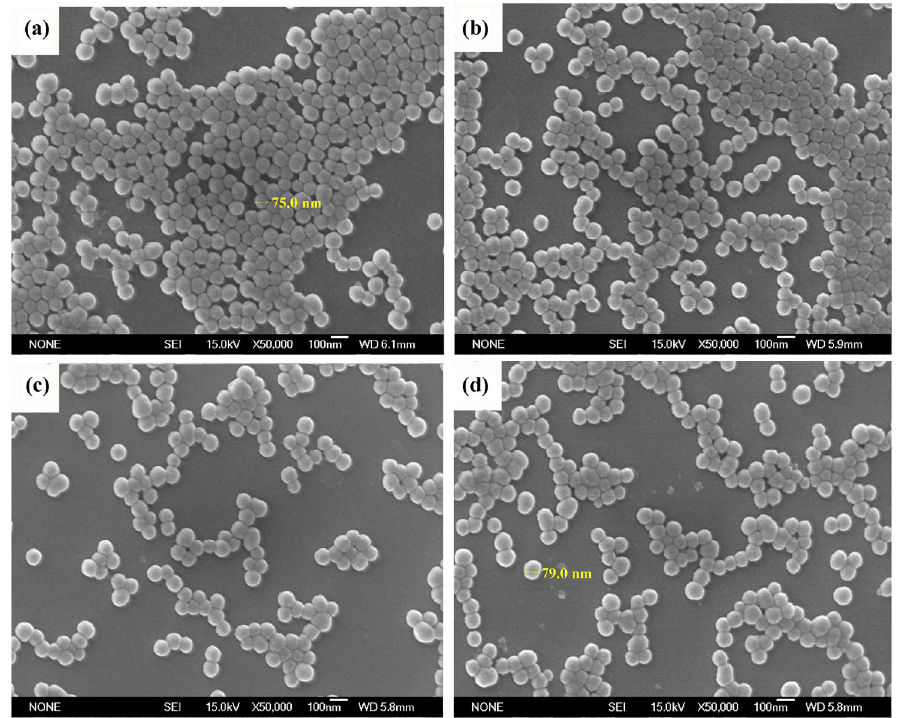
Fig. 2 The SEM images of colloidal silica abrasives and Ag-doped silica abrasives: (a) colloidal silica abrasives, (b) 0.5 wt% Ag 2 O, (c) 1.0 wt% Ag 2 O, and (d) 1.5 wt% Ag 2